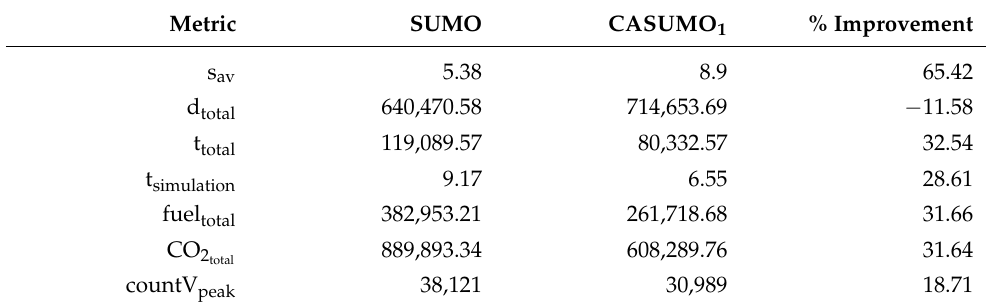
Table 10. Results and improvement of the proposed solution for 100 K+ simulated vehicles in Barcelona.